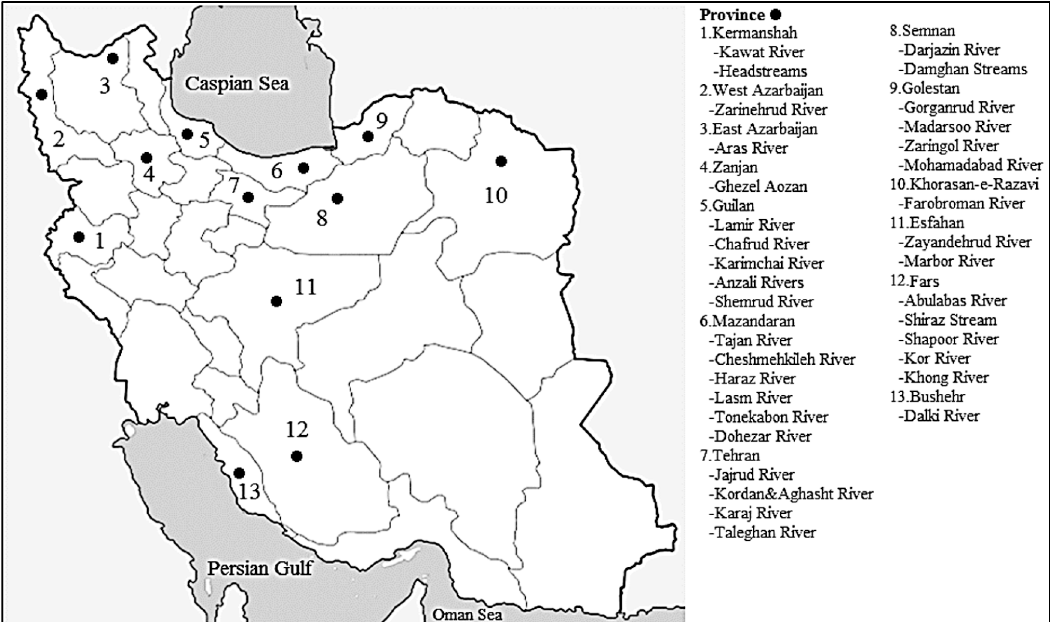
Figure 2. Map of Iran, showing the name of total rivers and streams in each province that recorded species composition of the